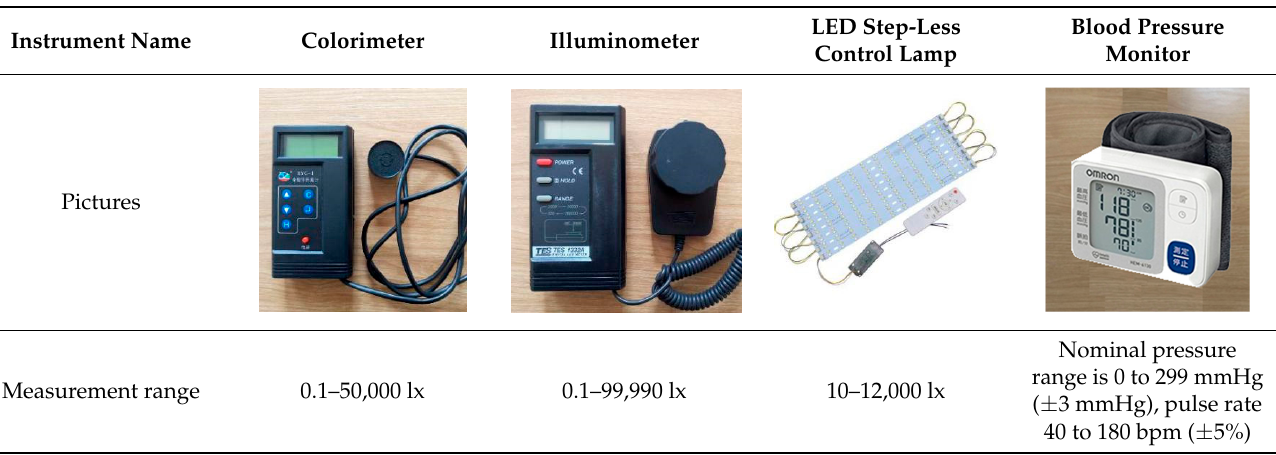
Figure 5. Photos of the control part of the experimental device. ( a ) DC power supply. ( b ) Single chip microcomputer.